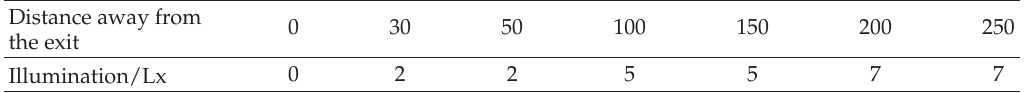
Table 5: Luminosity in entrance exit segment.